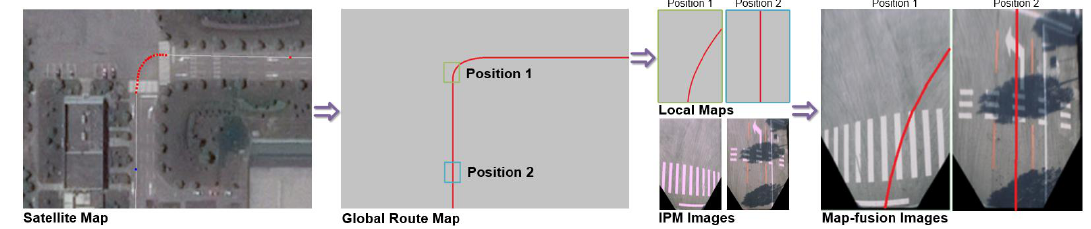
Figure 4. Generation of map-fusion images.